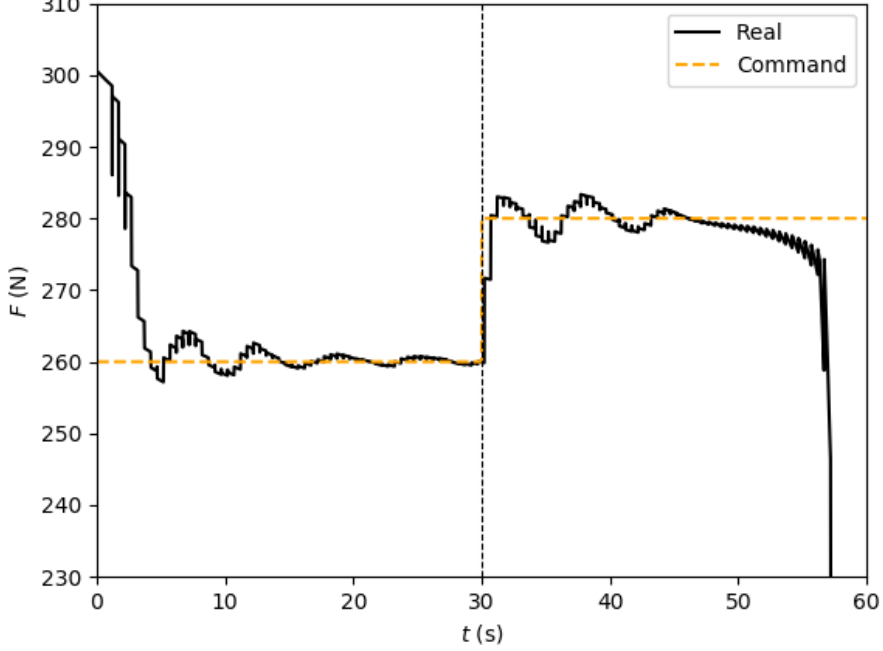
Figure 25. Thrust profile, feedback with downgraded regulation law, case